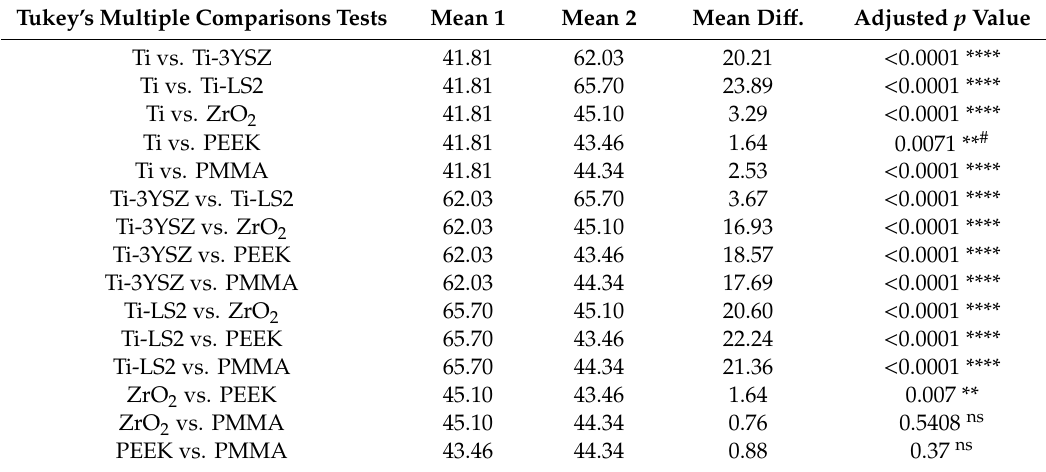
Table 4. Multiple comparisons of surface total SFE (mN / m) among groups ( n = 10 for each group) by Tukey’s test and significant di ff erence of means at the p ≤ 0.05 level: **** p < 0.0001; ** p = 0.007; ** # p = 0.0071. Non-significant (ns) p >